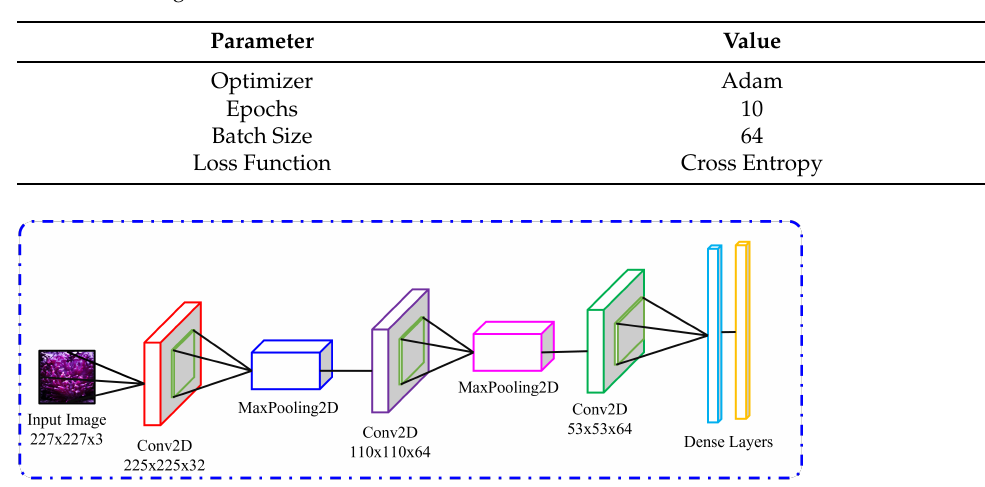
Figure 5. Feature Extraction with AlexNet. Table 1. Training Parameters of CoralNet.